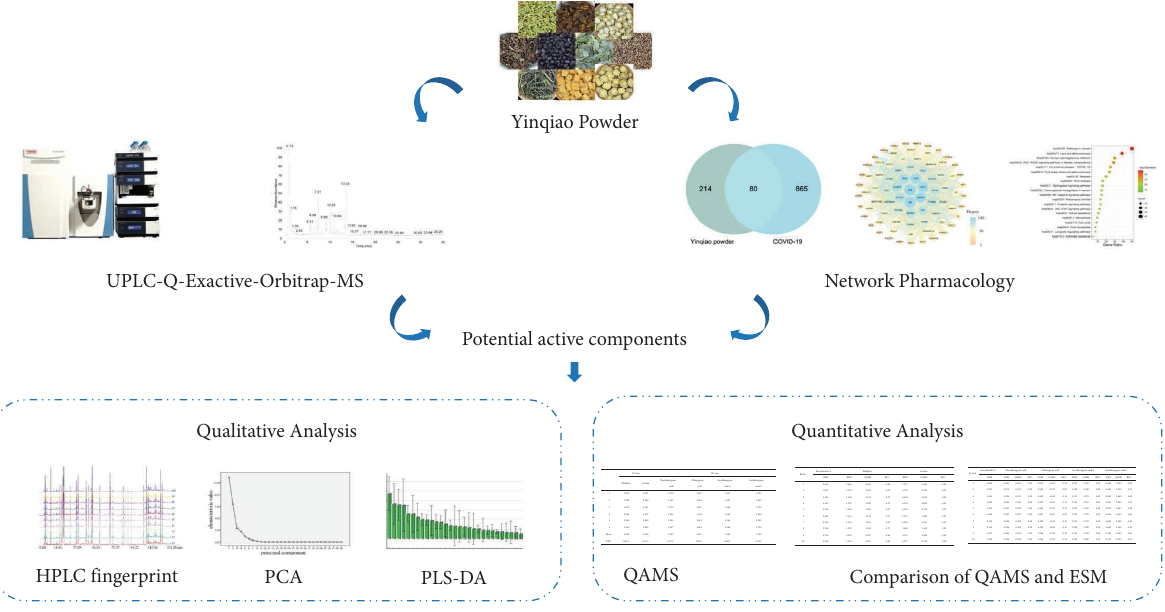
Figure 1: Flowchart of the established analytical Table 1: Information of the herbal slices in Yinqiao powder.